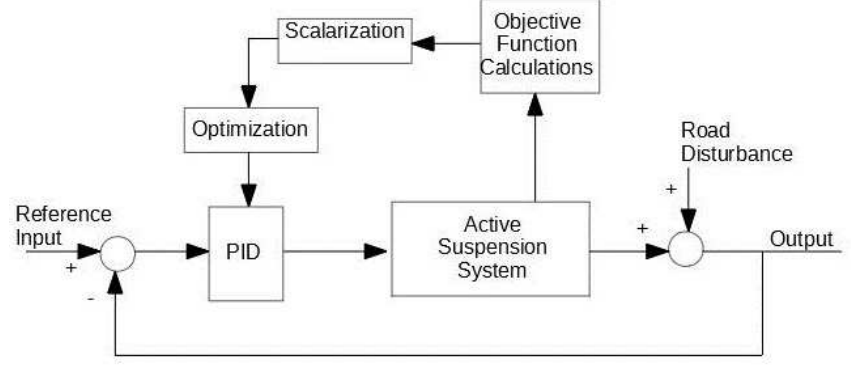
Figure 2. Control structure for quarter car suspension